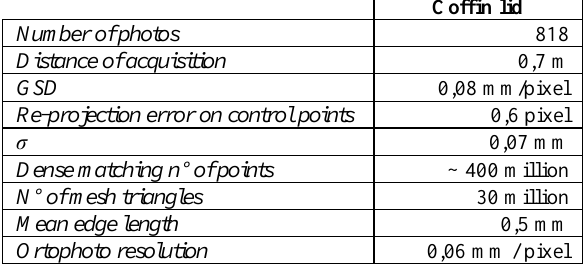
Table 2. Photogrammetric data.